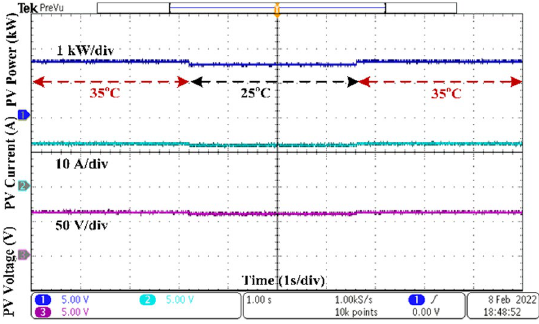
Fig. 26 PV voltage, power and current response for the proposed method in the presence of changing temperature